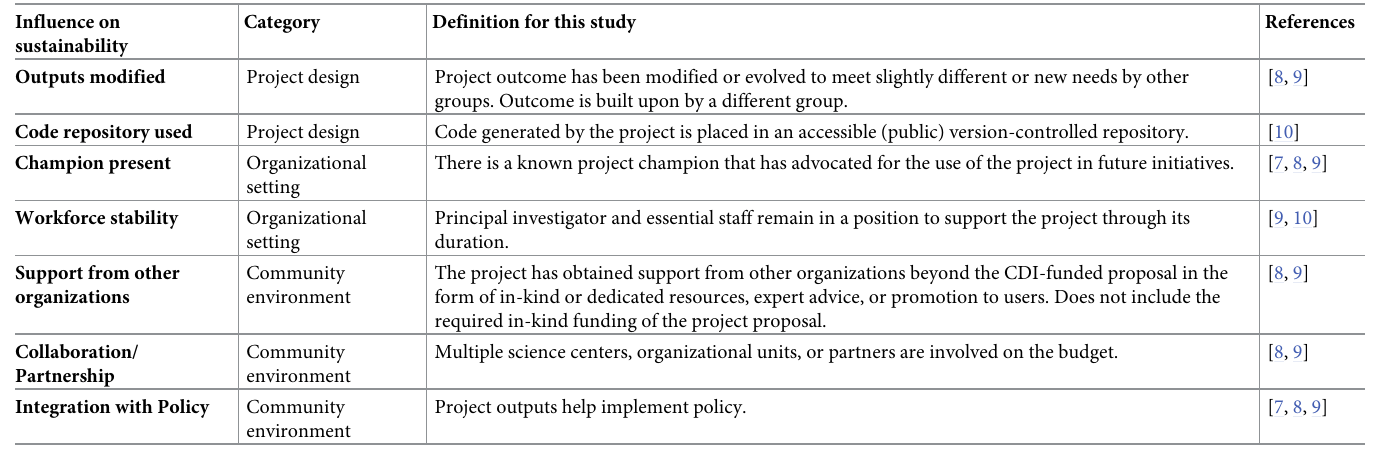
Table 5. Influences on sustainability, with their category, the definitions used in this study, and references to similar influences from other